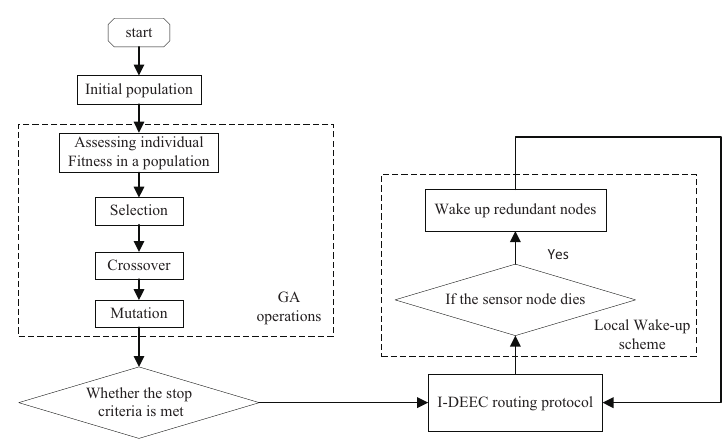
Figure 5. Flow chart of the combination of two algorithms.